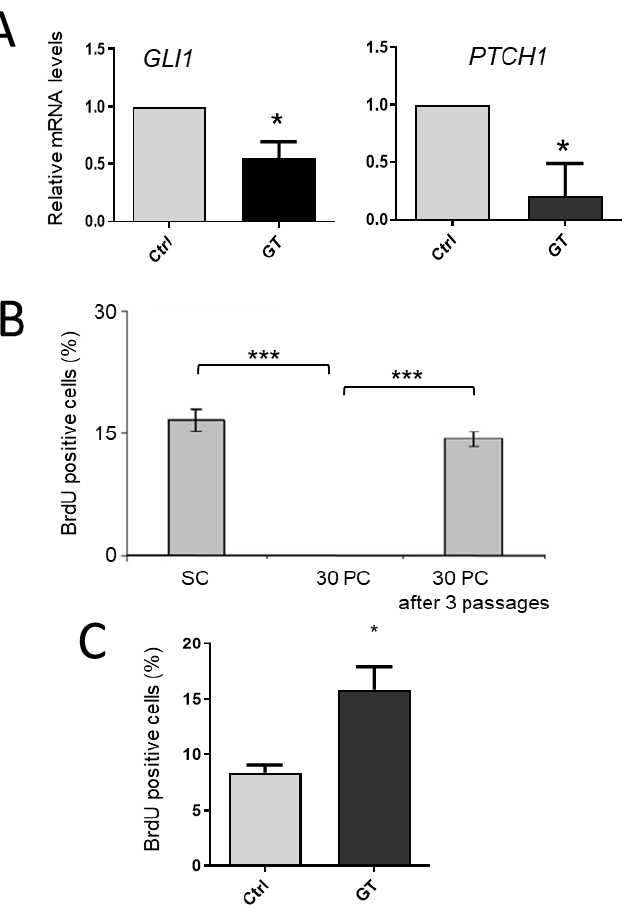
Figure 14. Quiescence of post-confluent HIEC cells is reversible and is regulated by the HH pathway. ( A ): In post-confluent HIEC-6 cells, the GLI1 inhibitor GANT-61 (GT) reduced the expression of both GLI1 and PTCH1 transcripts, the main HH downstream target genes, after 48 h treatment. ( B ): In contrast to sub-confluent (SC) cells, HIEC-6 cells that maintained up to 30 days of post-confluent (30PC) culture did not synthesize DNA as evaluated by the lack of BrdU staining. However, BrdU staining was restored to basal levels after 3 passages. ( C ): 20+ day-post-confluent HIEC-6 cells were treated for 48 h with GT before being passed and allowed to recover for 48 h then processed for BrdU staining and cell counting. *, p < 0.05; ***, p <0.001.